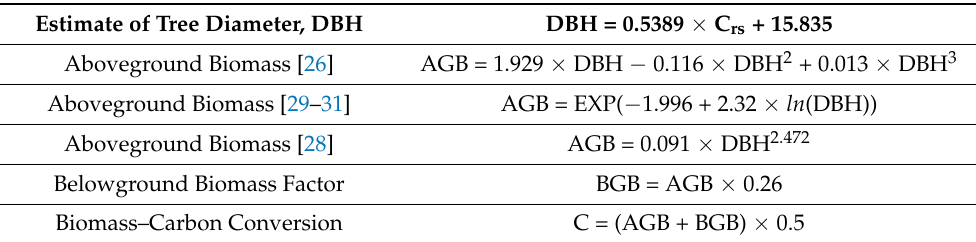
Table 1. Biomass allometry and carbon estimation parameters. Estimate of Tree Diameter,